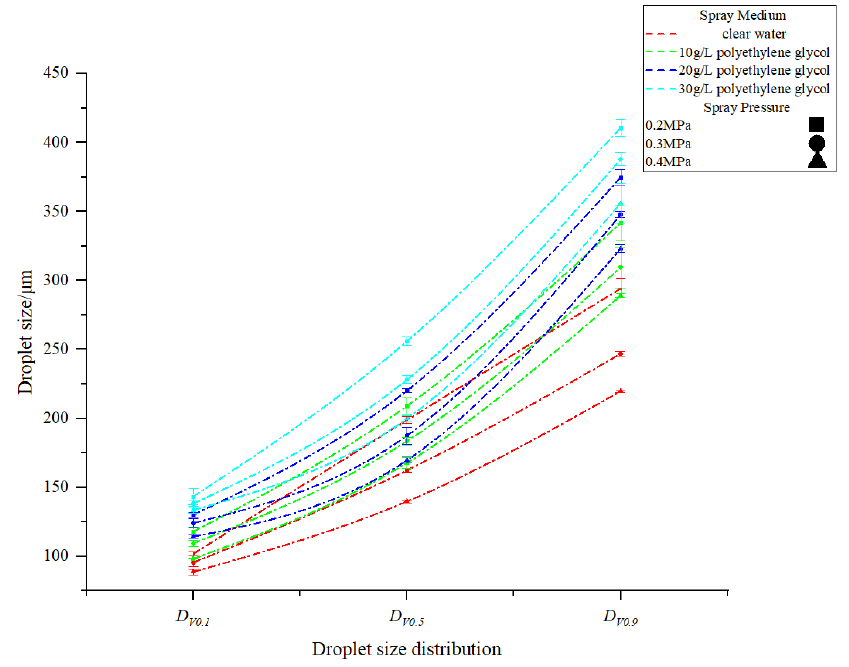
Figure 4. Droplet size distribution under different spray conditions.